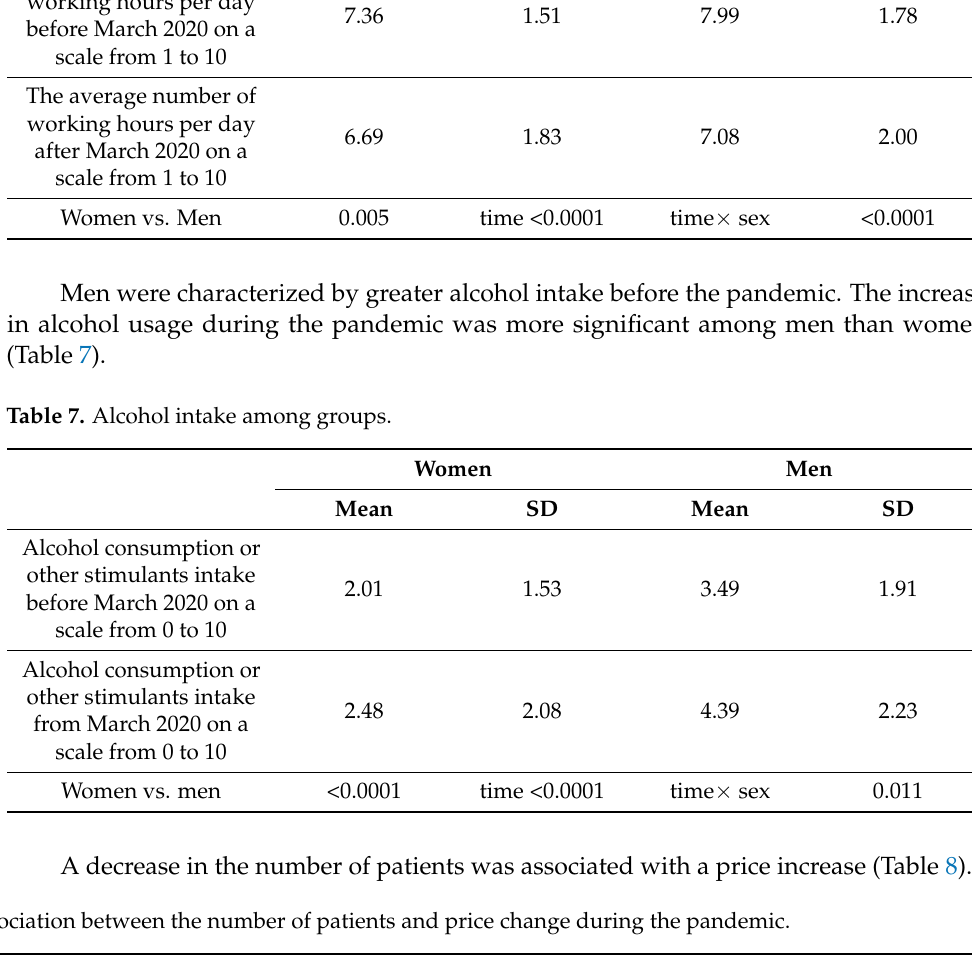
Table 8. Association between the number of patients and price change during the pandemic. Has the Number of Patients over the Last Six Months? Prices Not Changed Prices Decreased Decreased